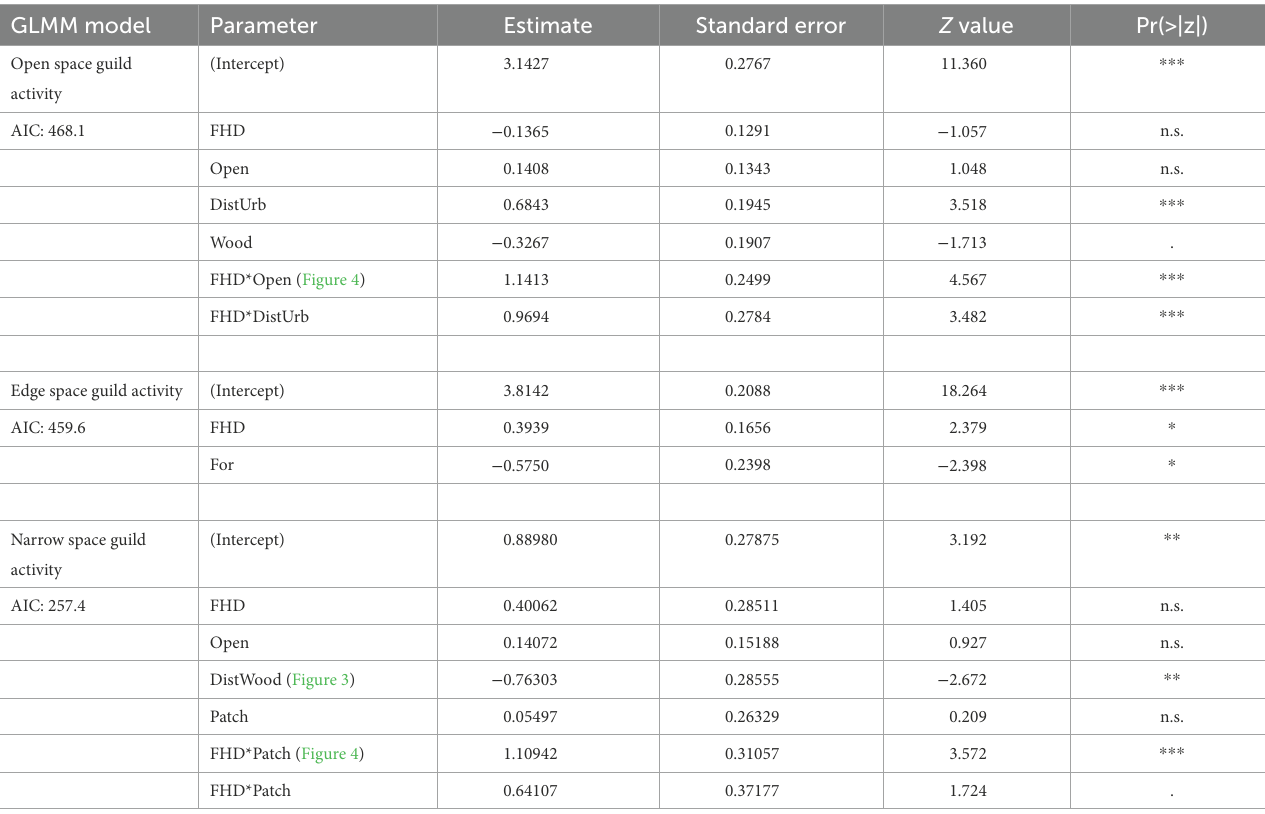
TABLE 3 Results of bat guild activity predictions from the forward selections of generalized linear mixed models (GLMM) with negative binomial links based on selection of the best Akaike’s information criterion (AIC). GLMM